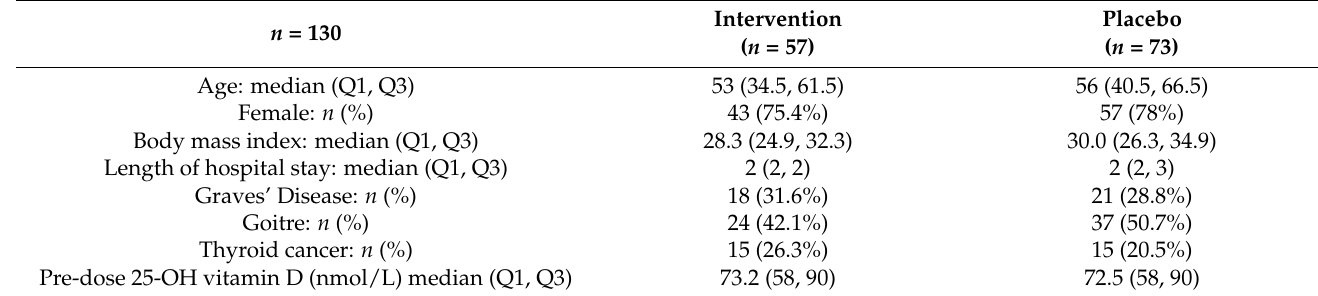
Table 1. Demographics and clinical parameters.